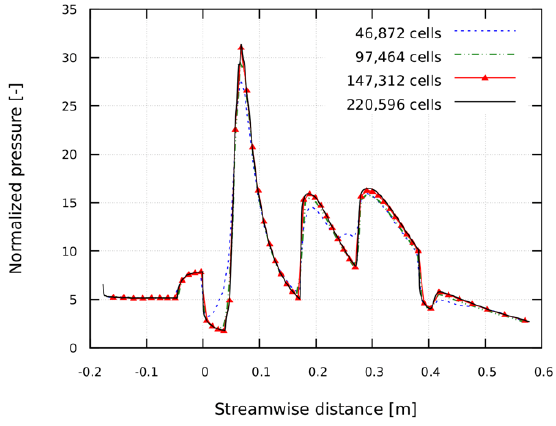
Figure 5. Grid independence for normalized pressure distributions along the bottom wall.